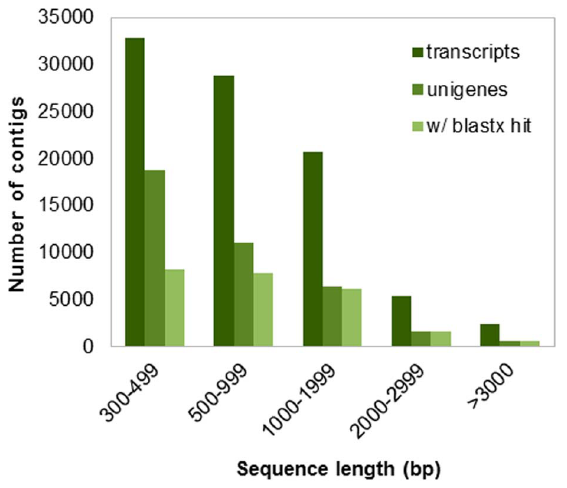
Figure 1. Denovo assembly length distribution. Histogram of the sequence-length distribution of transcripts, unigenes and unigenes with significant BLASTx hits in the NCBI nr database.